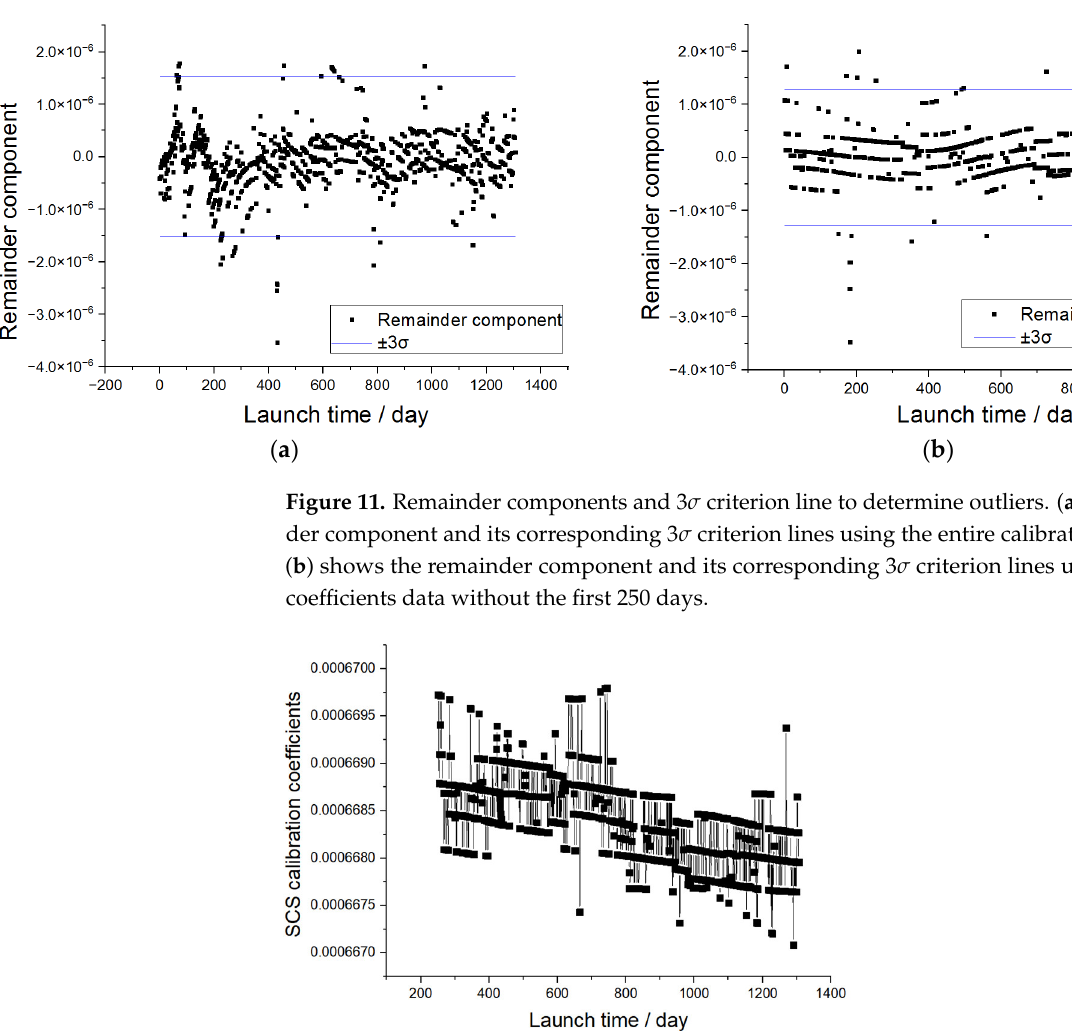
Figure 12. Corrected long-term SCS calibration coefficients using time series model.